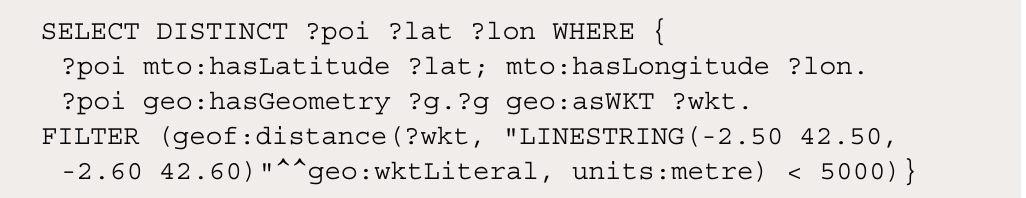
Figure 4. SPARQL query. Selecting POIs within 5 km of a given line.